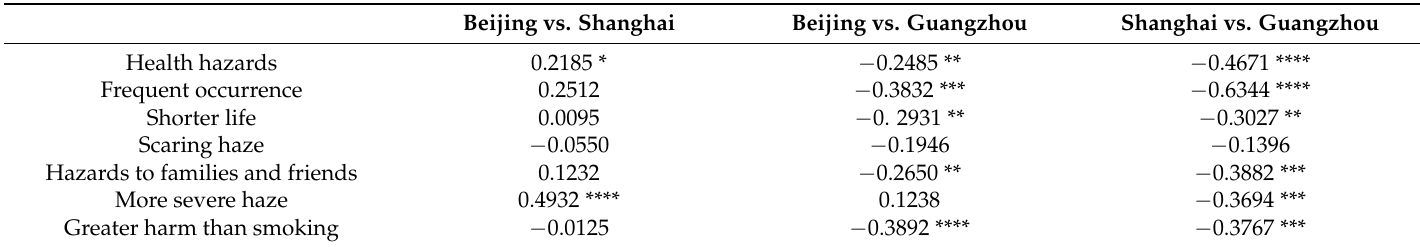
Table 8. ANOVA analysis of perceived risk among Beijing, Shanghai, and Guangzhou.